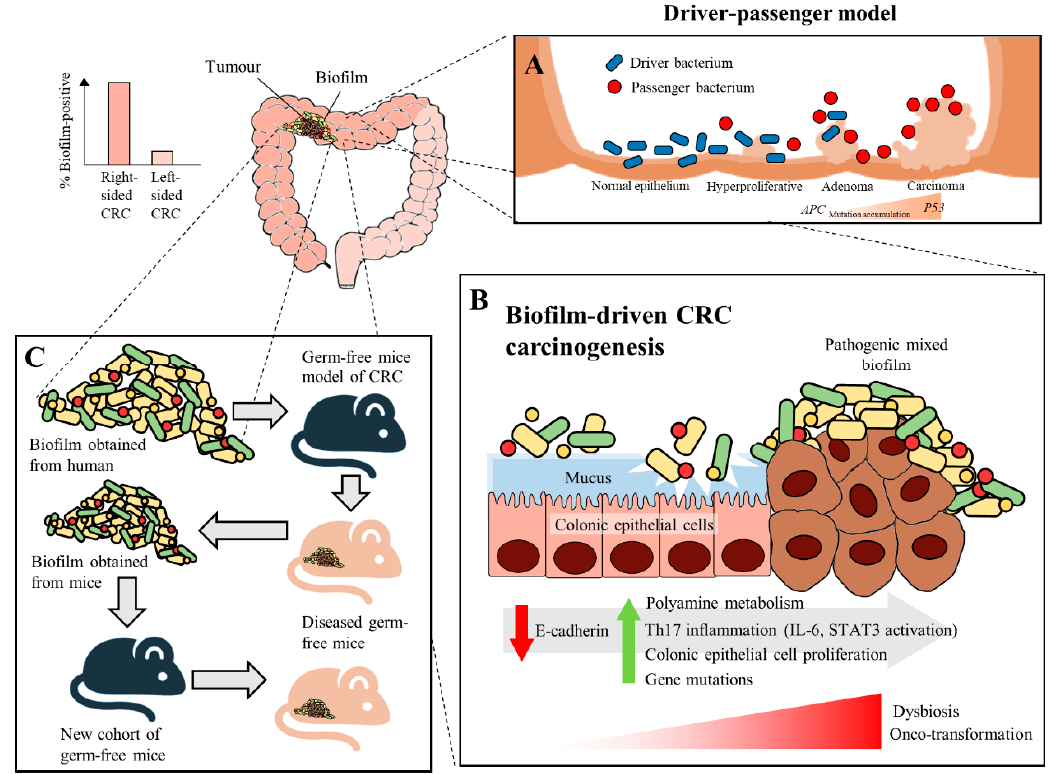
Figure 1. The role of colonic microbiota and biofilm in colorectal cancer (CRC) carcinogenesis. ( A ) The driver-passenger model for CRC carcinogenesis [39]. ( B ) Biofilm-driven CRC carcinogenesis. Biofilm results in loss of colonic epithelial cell E-cadherin (consistent with disrupted intestinal barrier function), increased IL-6 expression and STAT3 activation. These microbial biofilms contribute to a pro-oncogenic and pro-inflammatory state, coupled with the increased polyamine metabolism in colonic tissues, hence resulting in dysbiosis and onco-transformation and leading to tumor progression [11]. ( C ) The reassociation experiment showing that the microbiota communities from human biofilm-positive mucosa (healthy or CRC patients) resulted in CRC development in a new cohort of mice, indicates these biofilm-positive microbiota communities maintained their tumorigenic capacity [6].